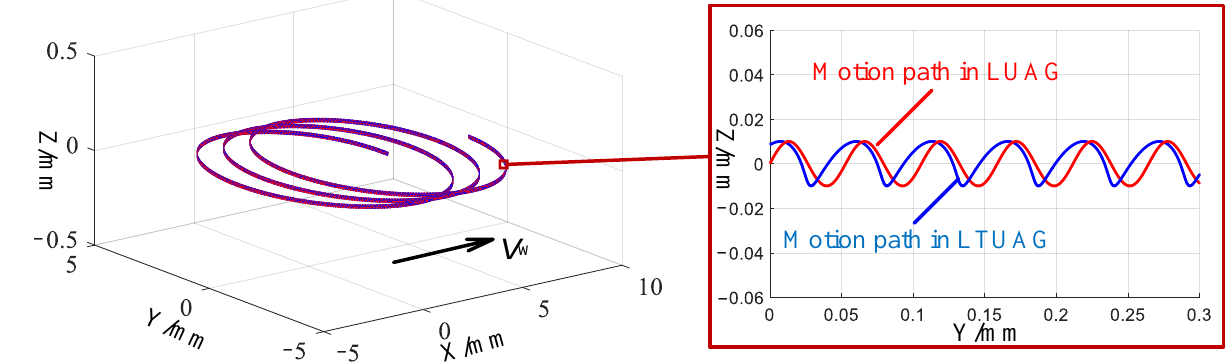
Figure 2. Trajectory of single abrasive in both LUAG and LTUAG.